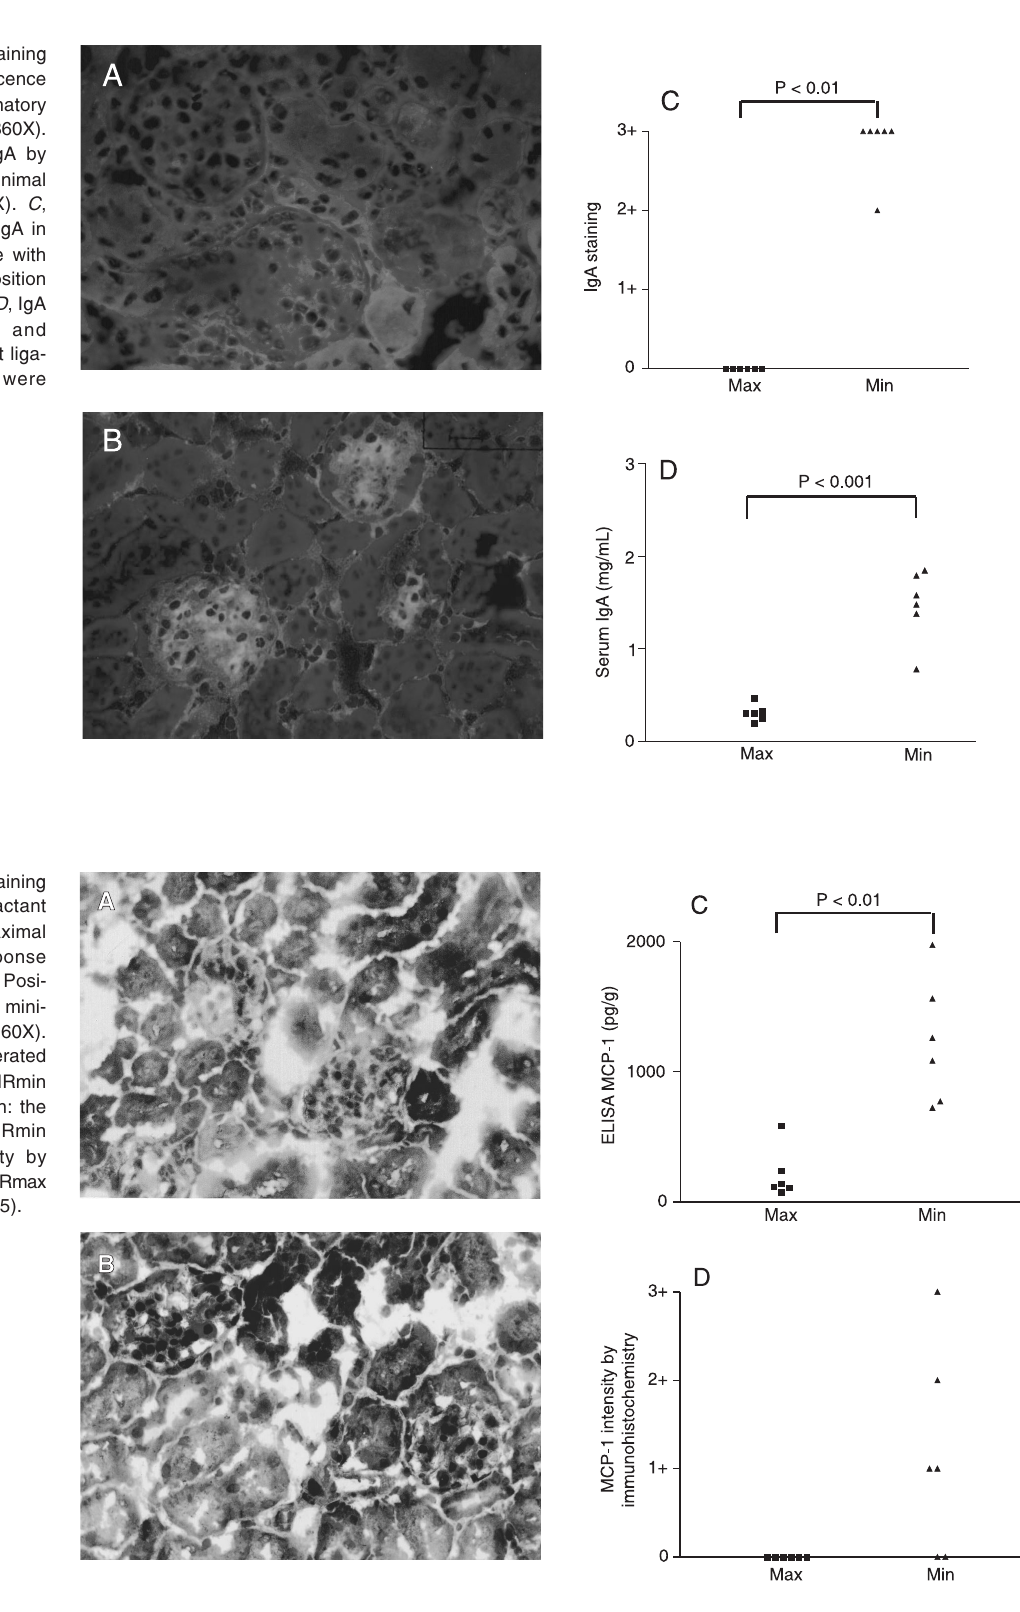
Figure 3. A , Negative staining for monocyte chemoattractant protein-1 (MCP-1) in maximal acute inflammatory response (AIRmax) mice (360X). B , Posi- tive staining for MCP-1 in mini- mal AIR (AIRmin) mice (360X). C , MCP-1 levels in macerated kidney from AIRmax and AIRmin mice with bile duct ligation: the levels were higher in AIRmin mice. D , MCP-1 intensity by immunohistochemistry in AIRmax and AIRmin mice (P >